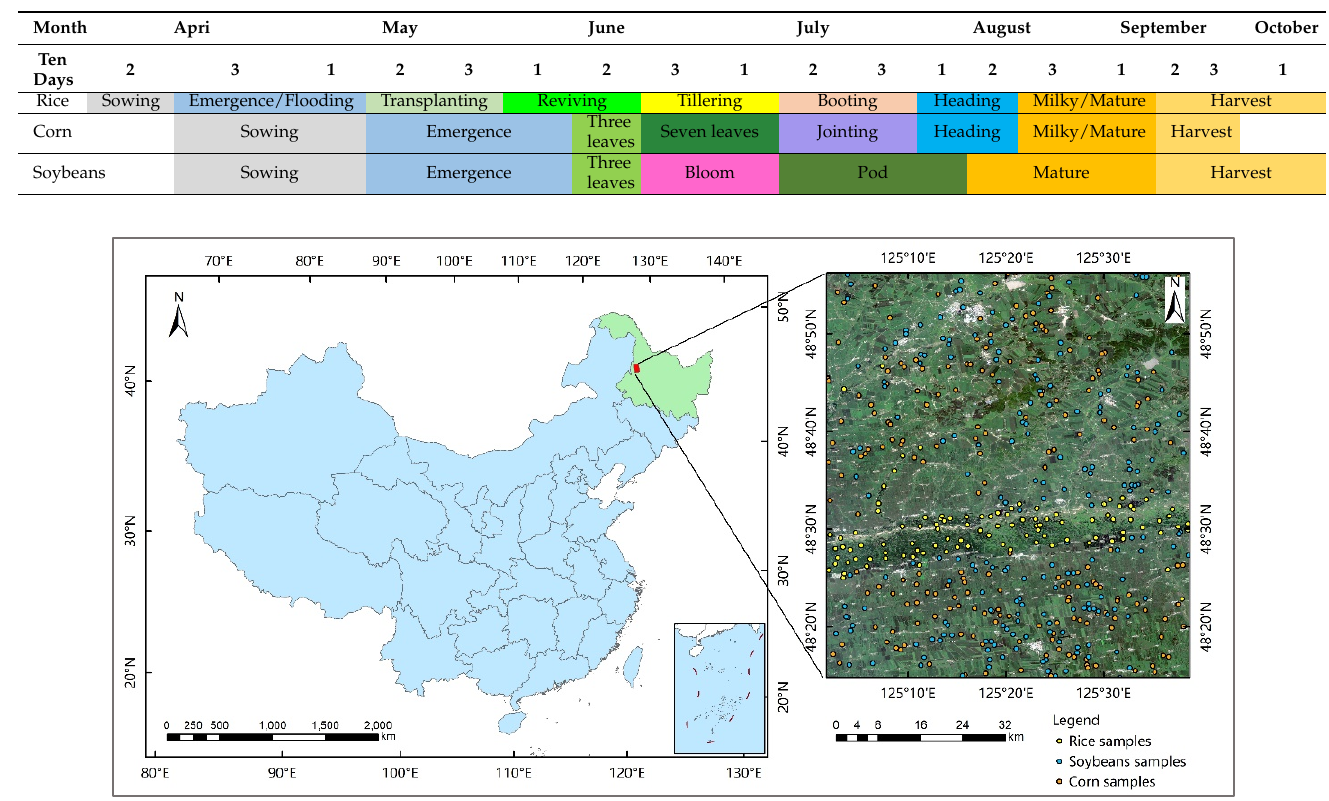
Table 1. Phenological periods of main crops in the studied region.